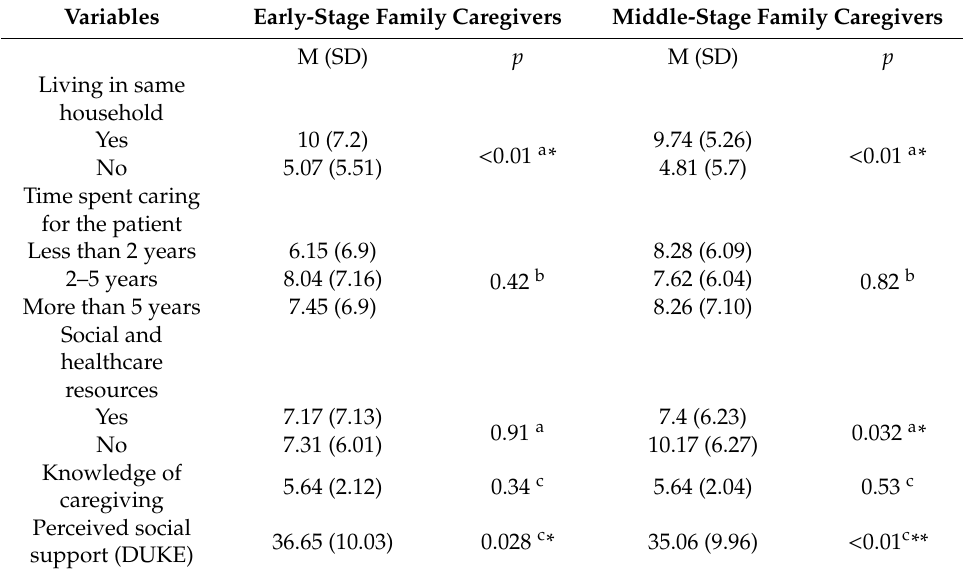
Table 3. Variables related to caregiving and perceived health, depending on the stage of the